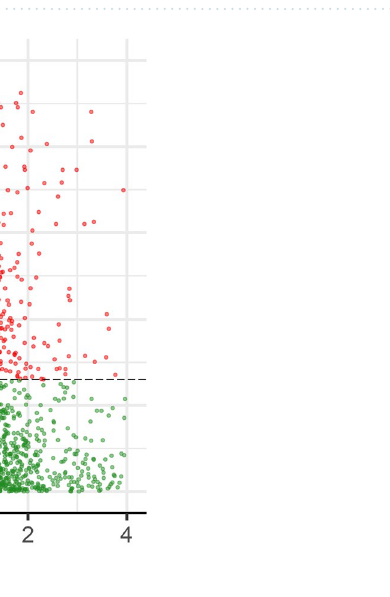
Figure 2. Gene expression comparison between normal and stress conditions. A volcano plot showing combined effect size (x-axis) and significance level (− log10-adjusted p-value; y-axis) for genes differentially expressed between normal and stress samples. The significant up and down-regulated genes are plotted as red